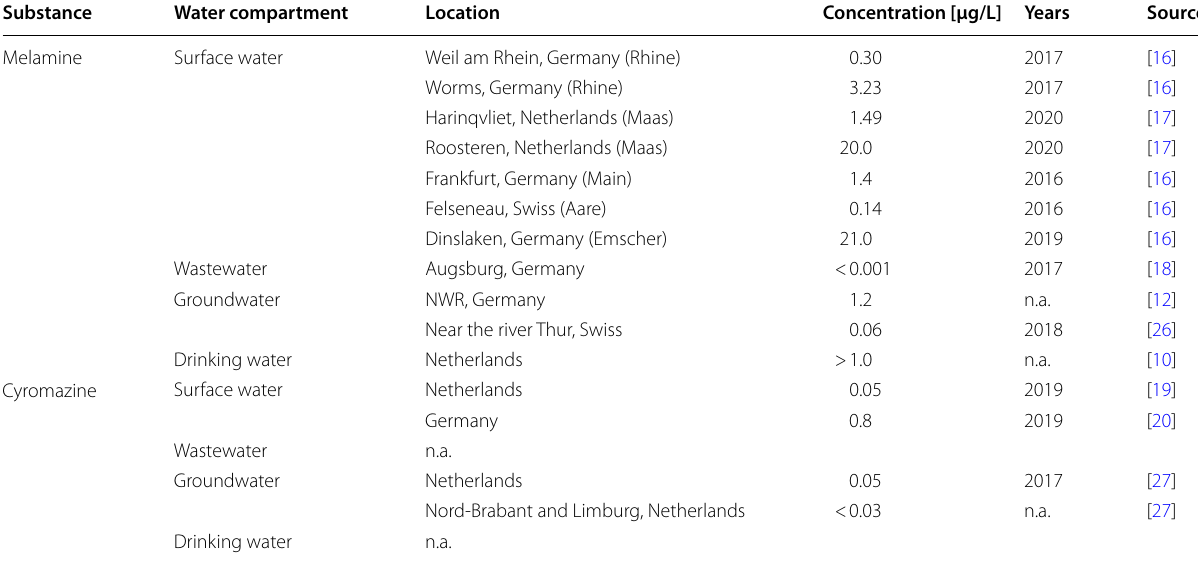
Table 1 Summary table of the concentrations of melamine and cyromazine in the different water compartments (surface water, wastewater, groundwater and drinking